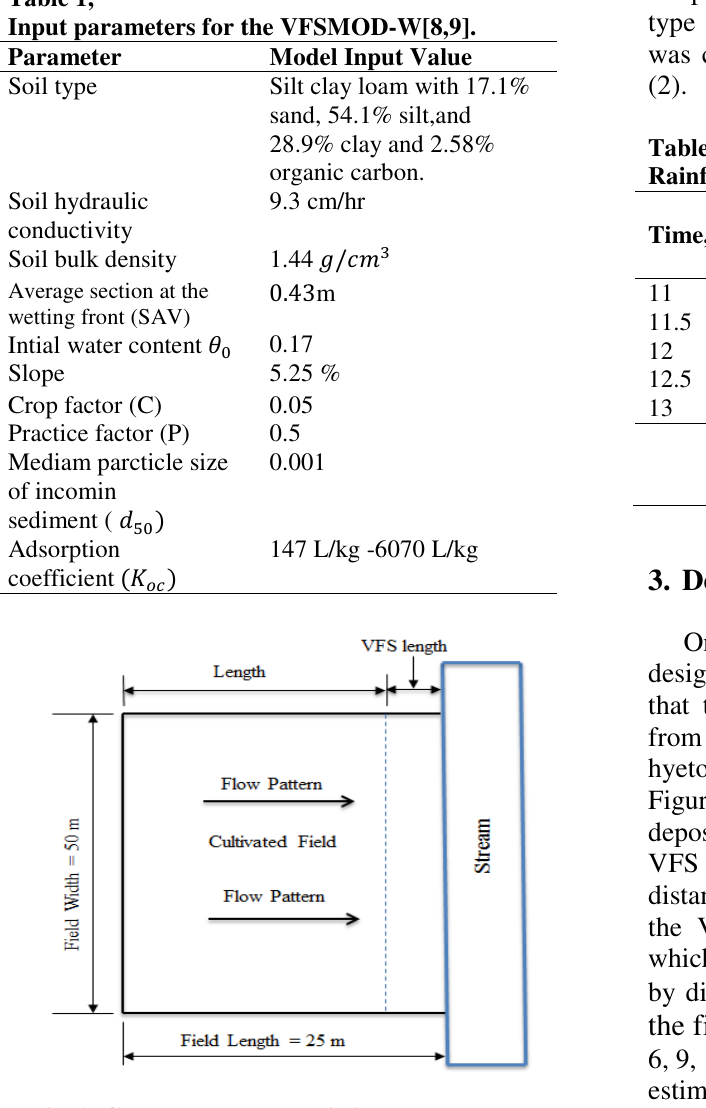
Fig. 2. Case study characteristics (source area).